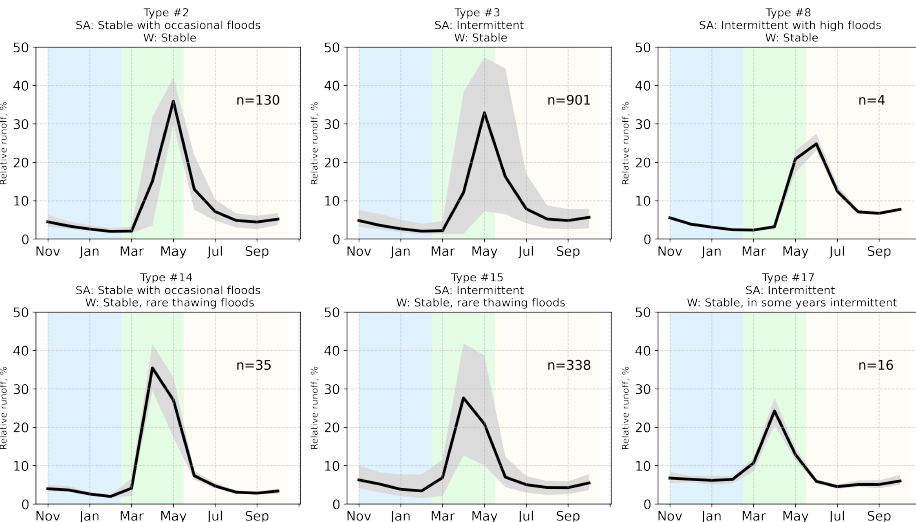
Figure 4. Monthly climatological hydrographs for different types of water regimes. Background color represents different seasons: blue for winter (Nov–Feb), green for spring (Mar–May), and yellow for summer–autumn (Jun–Oct). The abbreviations SA and W in the title refer to summer–autumn and winter periods, respectively.